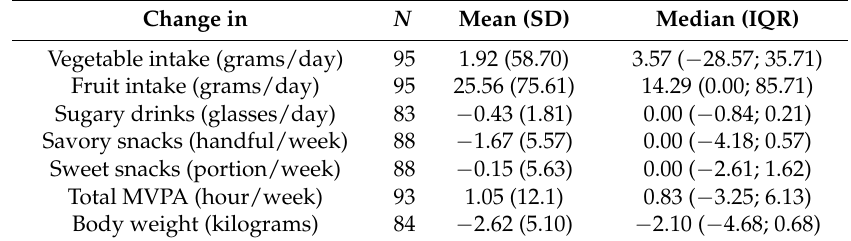
Table 2. Change in dietary intake, physical activity and weight during the first six months of the LIFEstyle study in the study population included for follow-up *.